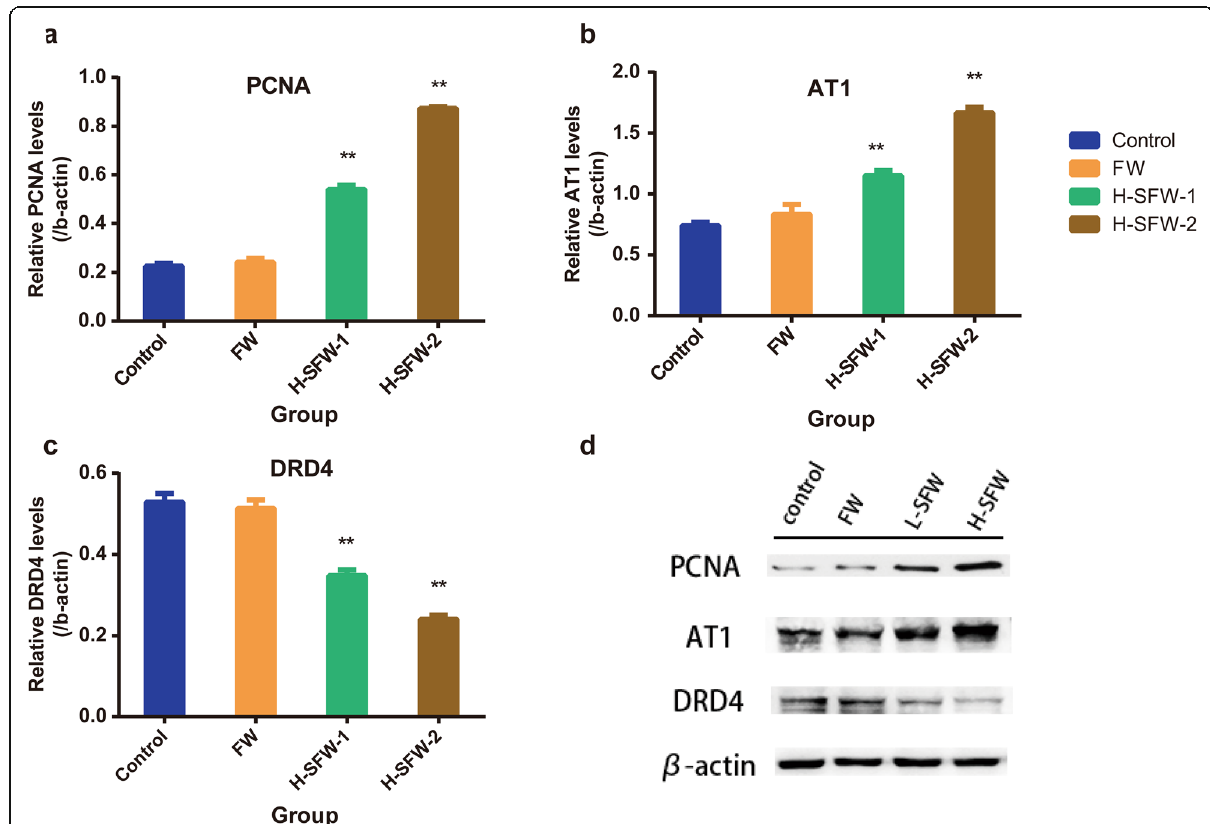
Fig. 2 Effects of different concentrations of NaCl in drinking water on protein expression of proliferating cell nuclear antigen (PCNA), angiotensin II type 1 (AT1) receptor and dopamine receptor D4 (DRD4) in vascular smooth muscle of broilers. a Expression of PCNA protein ( n = 6, ** P < 0.01 vs. control). b Expression of AT1 receptor protein ( n = 6, ** P < 0.01 vs. control). c Expression of DRD4 protein ( n = 6, ** P < 0.01 vs. control)